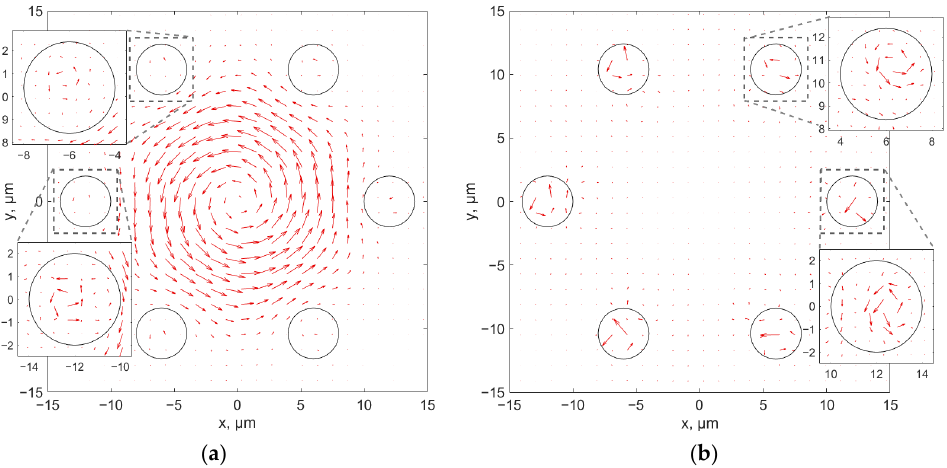
Figure 7. Spin ( a ) and orbital ( b ) parts of the transverse component of the Poynting vector of the fundamental core mode of the ASBGF with parameters given in the text for circular polarization. The calculation was made at wavelength of 1 µm.